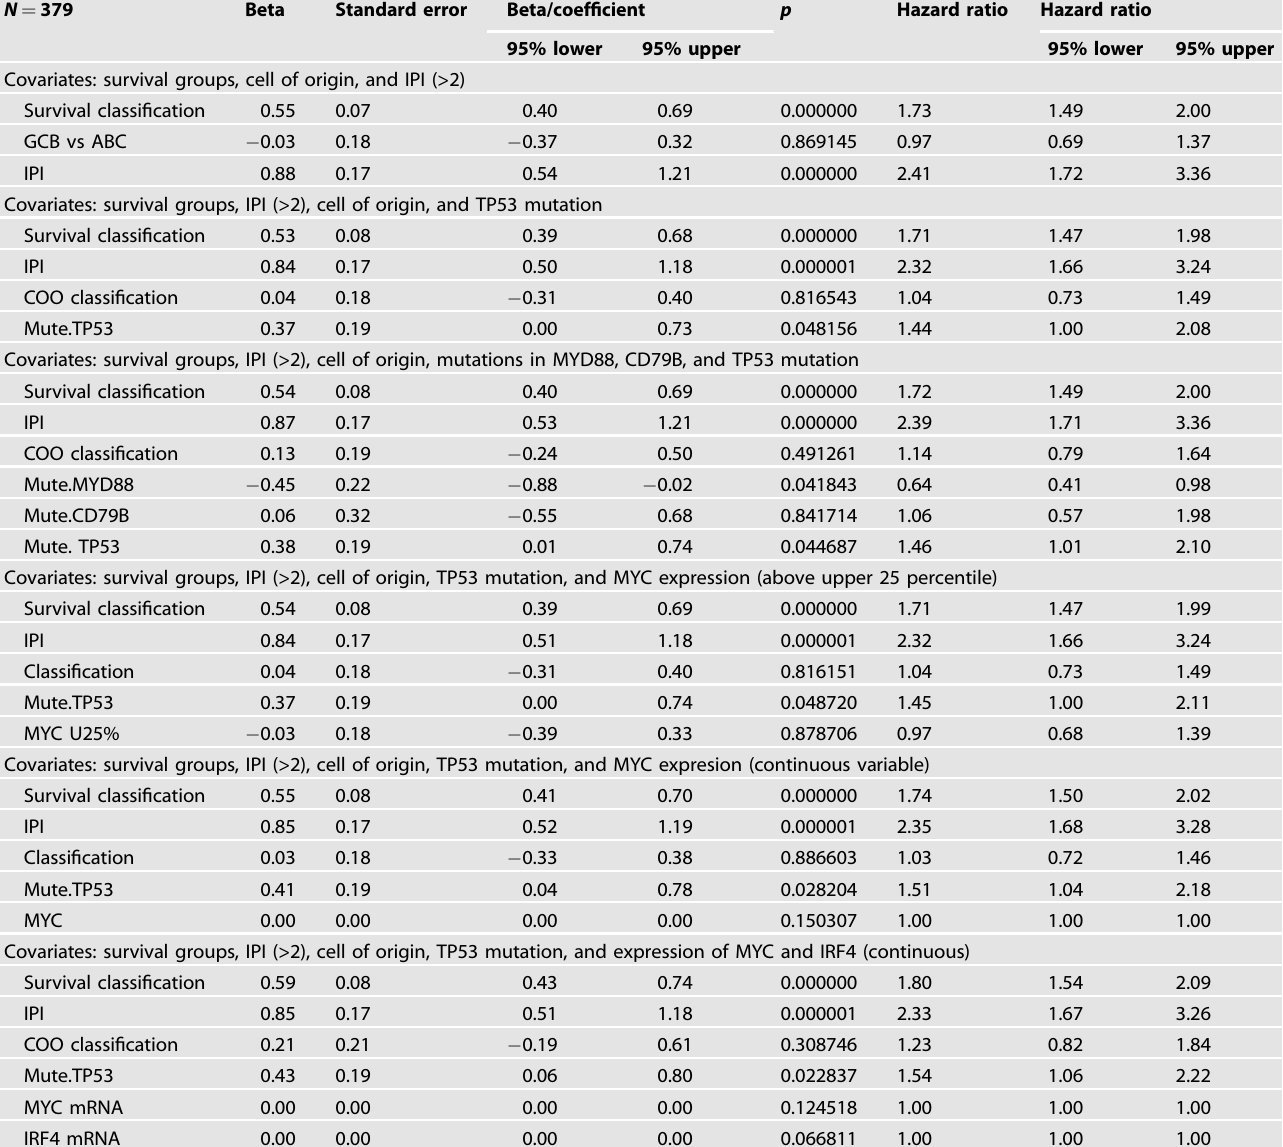
Table 1. Multivariate survival